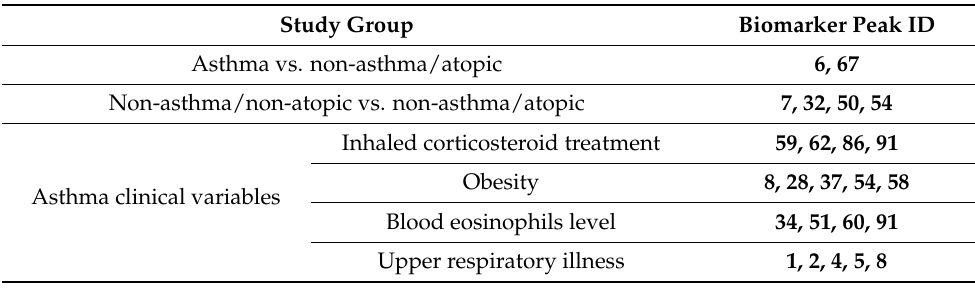
Table 2. Summary of the different study groups and respective identified biomarker IDs.